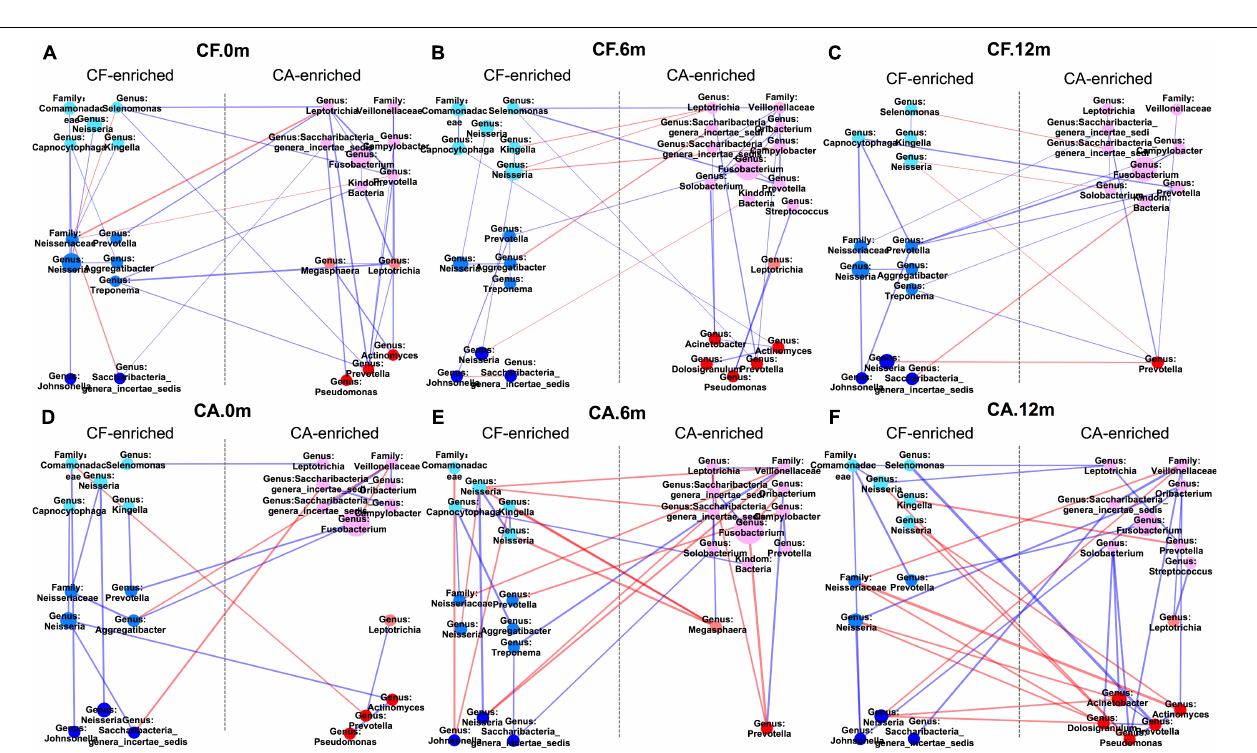
FIGURE 3 | Comparison of OTU relative abundances in supragingival microbiome between CF and CA groups. Differences in relative abundance at OTU level were analyzed using the Wilcoxon rank-sum test, P < 0.05 was considered to reflect a significant difference. Not significant difference was not shown. The bars represent “mean ± SD” relative abundances. (A) Comparison of OTU relative abundances between CF and CA group at baseline. (B) Comparison of OTU relative abundances between CF and CA group at 6-month follow-up. (C) Comparison of OTU relative abundances between CF and CA group at 12-month follow-up.